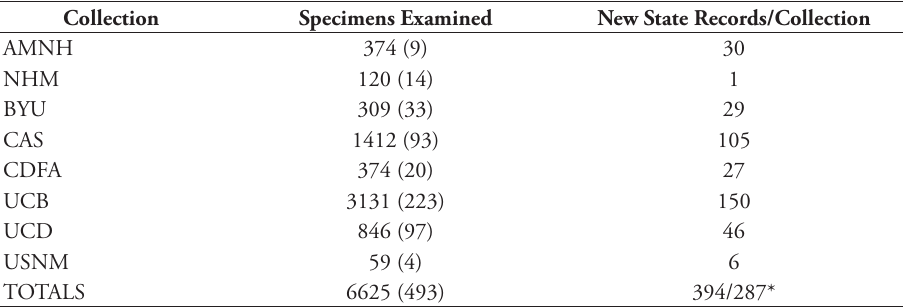
Table 1. Indoor Collecting. Numbers of specimens examined, by institutional collection. For Specimens Examined, the number in parentheses are those not determined to